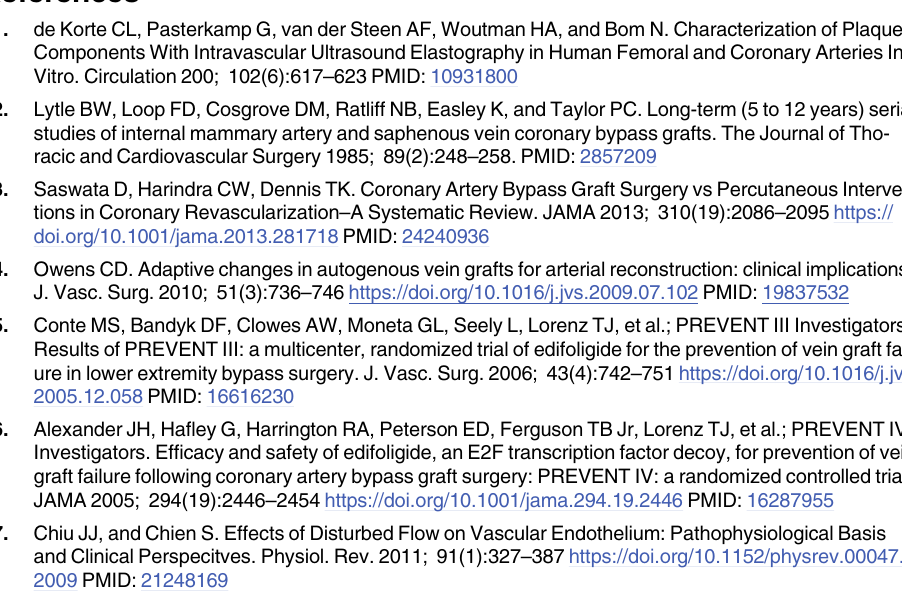
“Sorted List” includes the list of all the grafts used for the analysis with the mean values of all the significant biological measurements, and the sheet “Final tables” includes the mean values of all the significant biological measures under high, low, and intermediate shear along with their correspondent temporal plots.